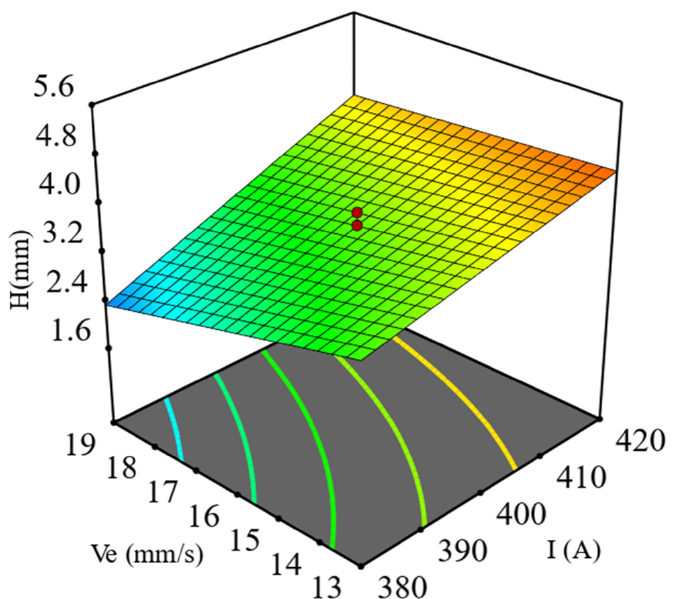
Figure 5. Bead-height perturbation graph.